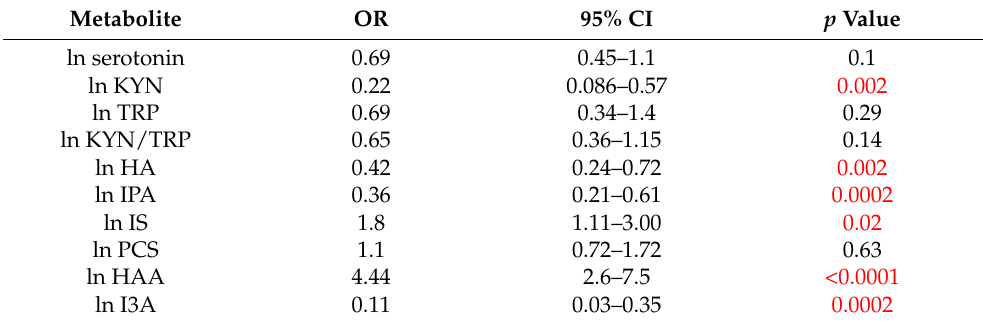
OR, odds ratio. CI, confidence interval. All other abbreviations are as described in the text. Red values indicate p < 0.05.